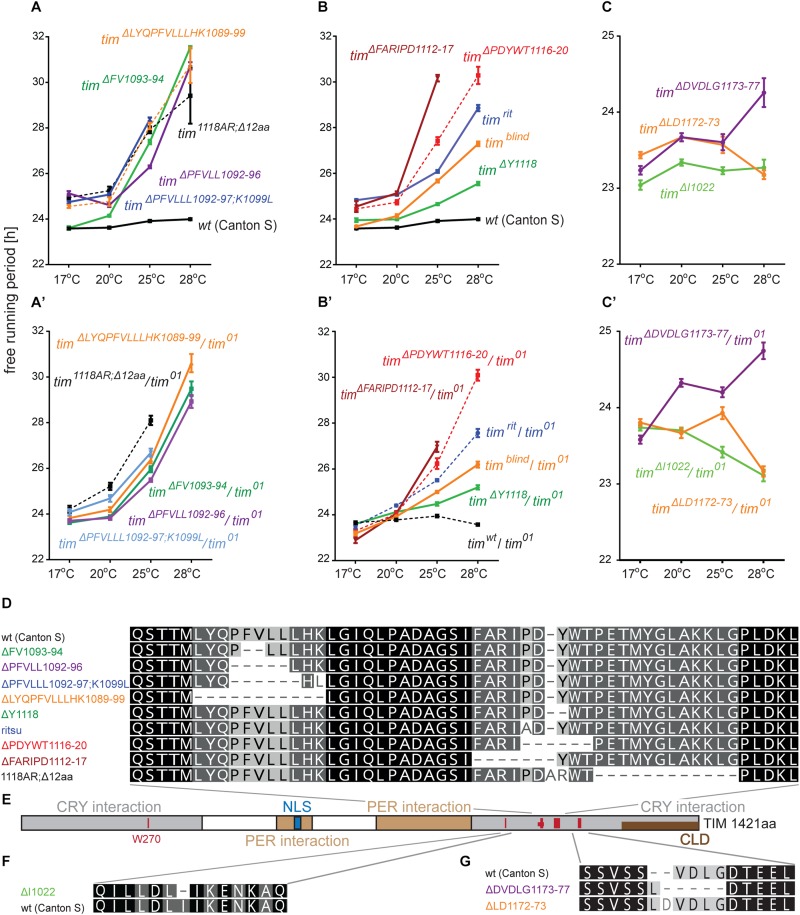
Summary of phenotypes for homozygous (A–C) and heteroallelic combinations with tim01
(A’–C’) mutants isolated in vicinity of timrit and timblind. Name of each mutation is color-coded to ease orientation in the sequence alignments (D,F,G). (E) Schematic depiction of TIM protein with position of mutated regions (red bars), nuclear localization signal (NLS), PERIOD interacting domain (PER interaction), CRYPTOCHROME interacting domain (CRY interaction), and cytoplasmic localization domain (CLD). Dashes (−) correspond to gaps in the alignment (which result from insertions or deletions). For statistical comparison between mutants and heteroallelic combinations, see Supplementary Figure S5.